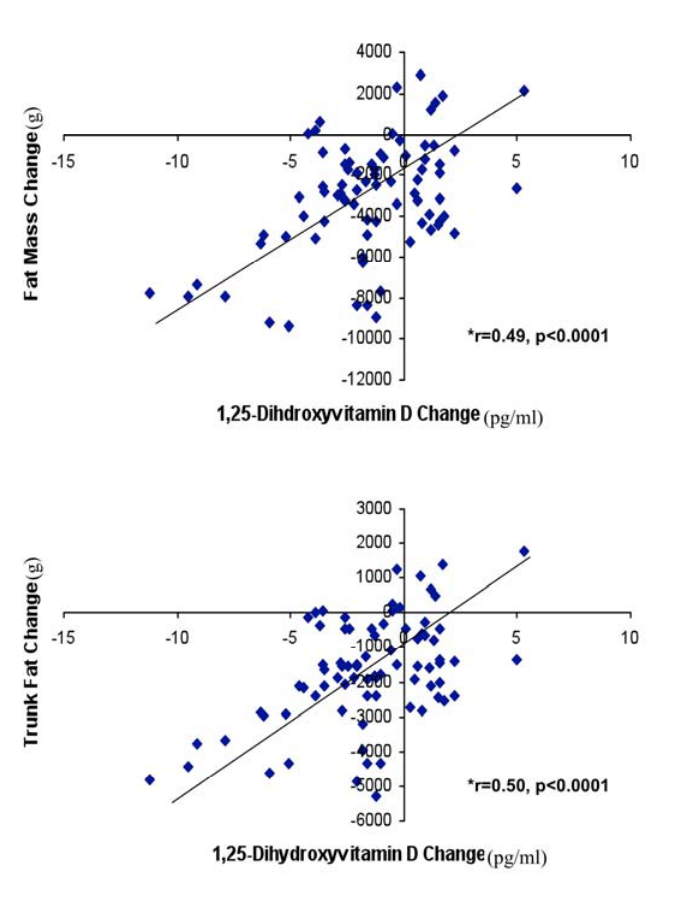
Figure 6. Correlation between change in plasma 1,25-dihydroxyvitamin D and change in total body fat (upper panel) and trunk fat (lower panel) among all subjects completing the